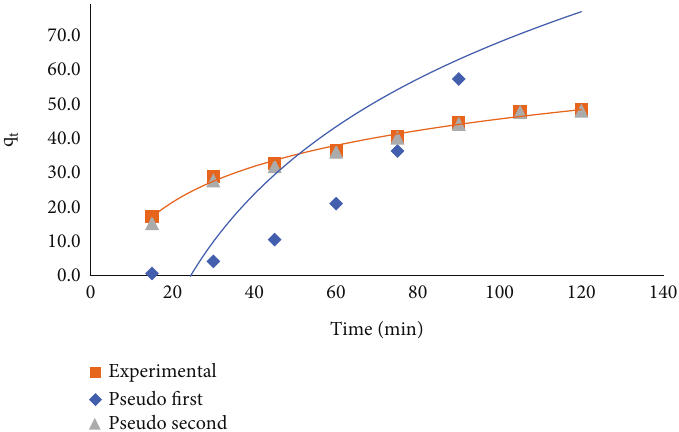
Figure 8: In fl uence of pH on the adsorption of PA onto ACO ( dosage = 50 mg , C T = 25 ± 1 ° C).